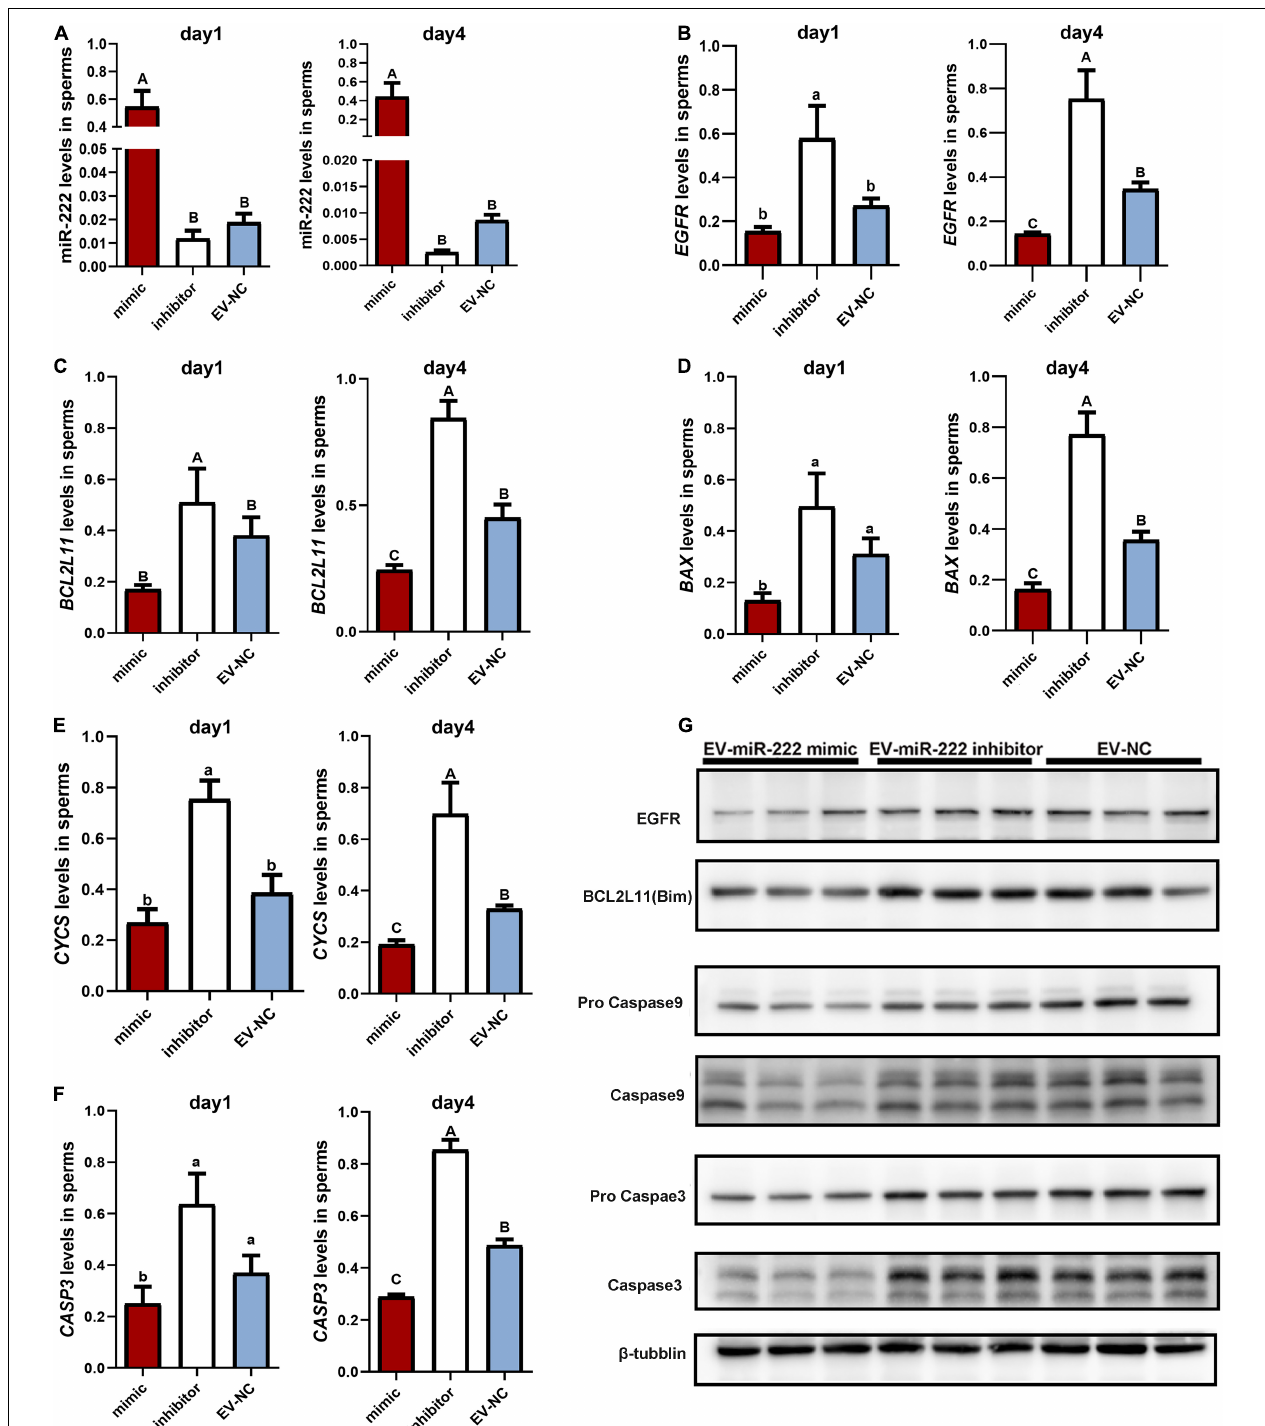
FIGURE 5 | Effect of miR-222 on porcine sperm in vitro . (A) The relative expression levels of miR-222 in sperm incubated with SPEVs for one day and four days were determined by qPCR. (B–F) The relative expression levels of EGFR (B) , BCL2L11 (C) , BAX (D) , CYCs (E) and CASP3 (F) in sperm incubated with EV-miR-222 mimic, EV-miR-222 inhibitor and EV-NC for one day and four days were determined by qPCR. (G) The protein expression levels of EGFR, BCL2L11 (Bim), pro Caspase9 and Caspase9, pro Caspase3 and Caspase3, and tubulin in sperm incubated with EV-miR-222 mimic, EV-miR-222 inhibitor and EV-NC for four days were determined by WB. From (A–F). data are presented as mean ± SEM. Different capital letters indicate significantly different values at P ≤ 0.01, different lowercase letters indicate significantly different values at P ≤ 0.05 (ANOVA), n = 3 for each group.